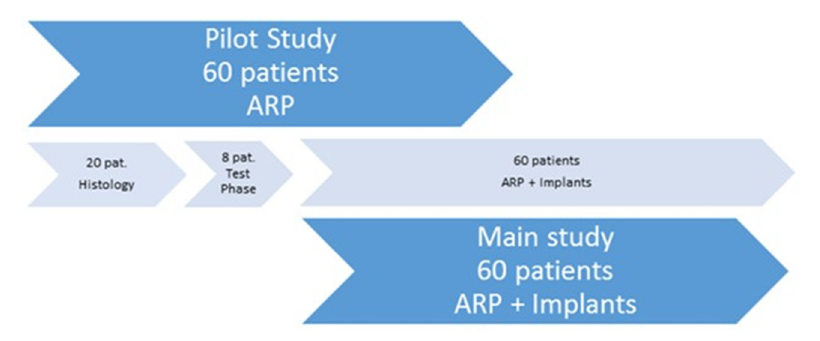
Figure 1. Division of patients into the pilot study and the main study. ARP: alveolar ridge